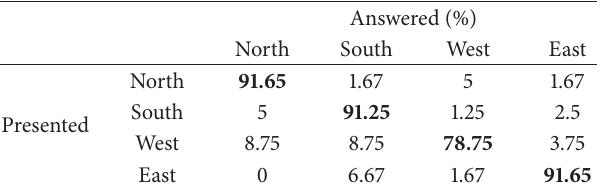
Figure 4: Prototypes 2 and 3: schedule of activation of the vibrating actuators for the direction recognition task. Example for North. Table 2: Direction recognition rates with prototype 2.